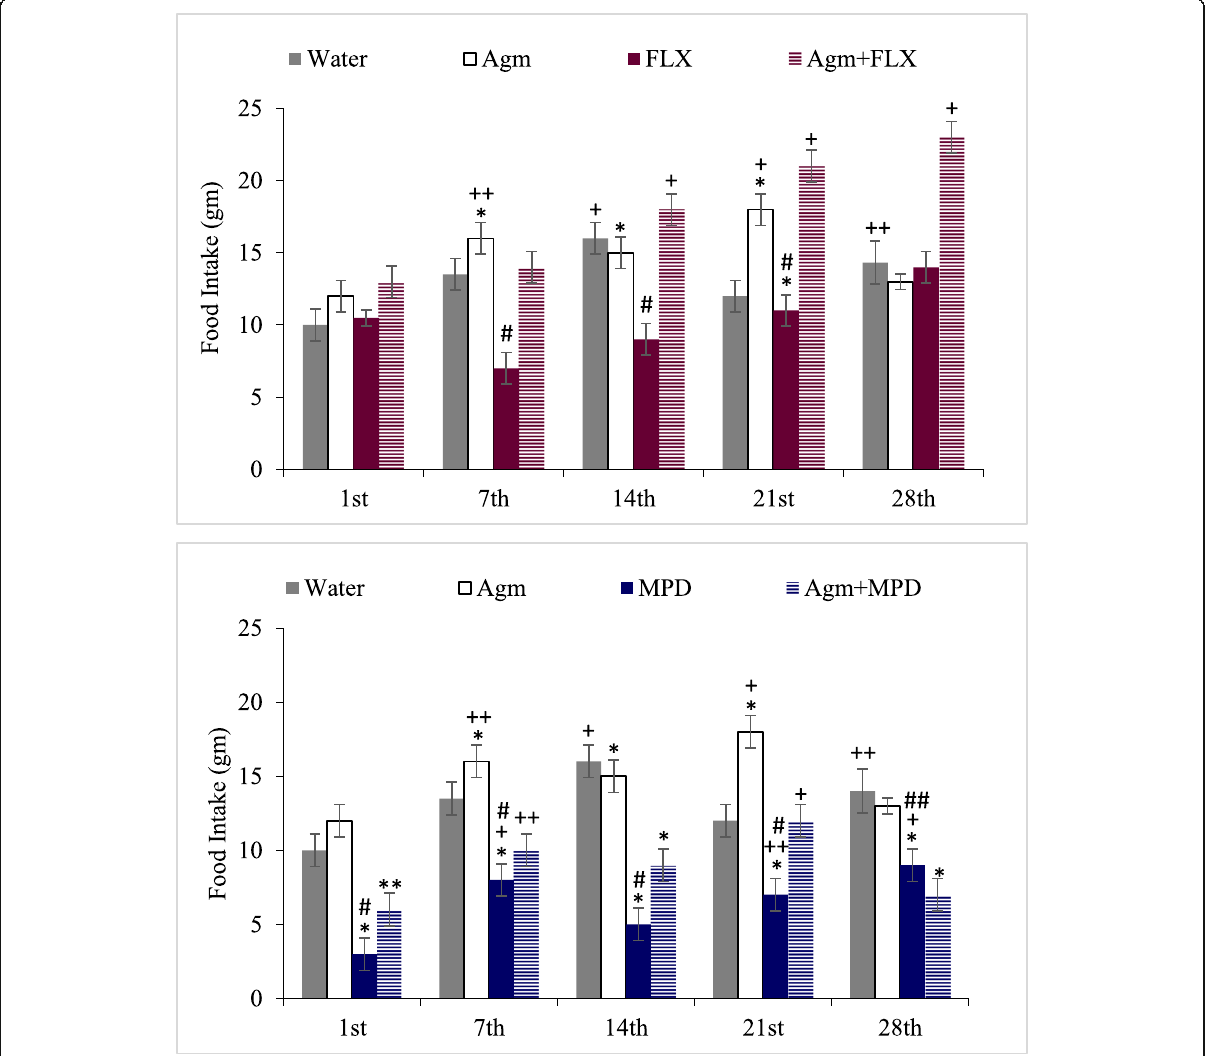
Fig. 4 Food intake: values are expressed as means ± SD ( n =6). Significant differences by Newman-Keuls test: * p <0.01, ** p <0.05 from water-treated control group to drug-treated groups. + p <0.01, ++ p <0.05 from drug ’ s 1st administration. # p <0.01, ## p <0.05 from AGM-treated animals to